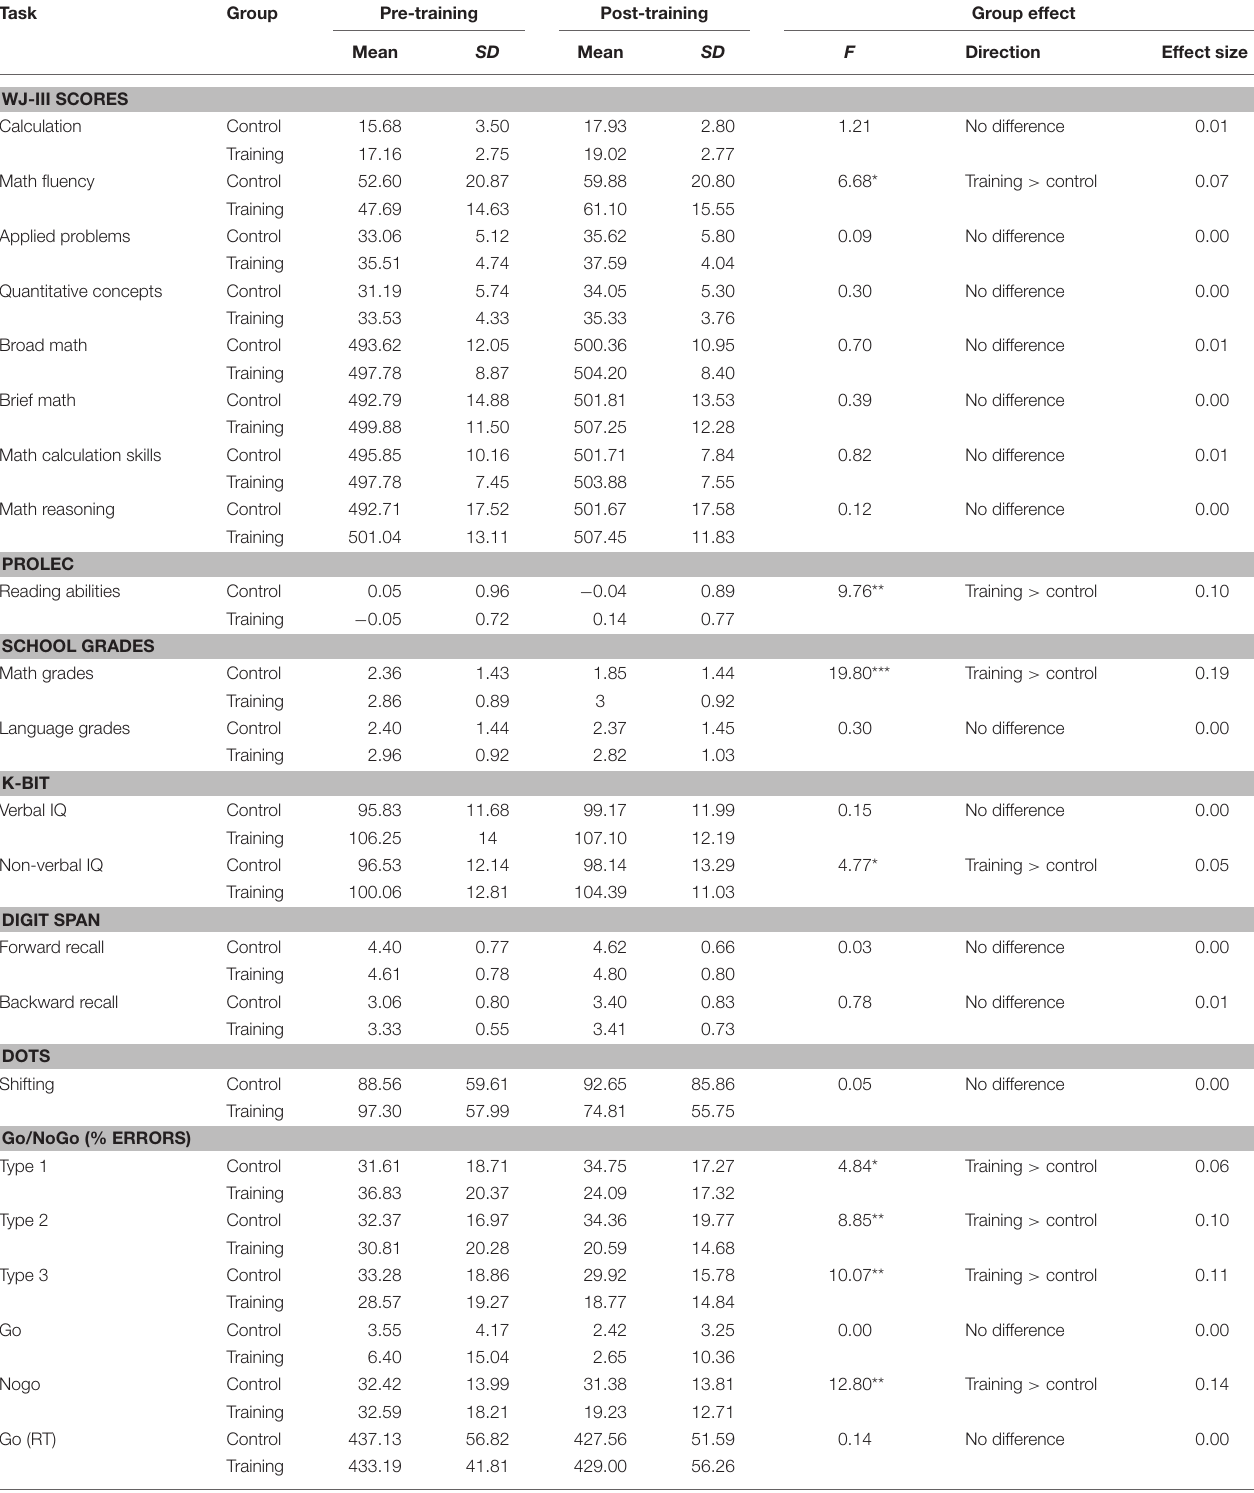
TABLE 2 | Training vs. control groups on the pre- and post-training assessments: means, standard deviations, the results of ANCOVAs (control vs. training groups) and effect sizes (partial eta